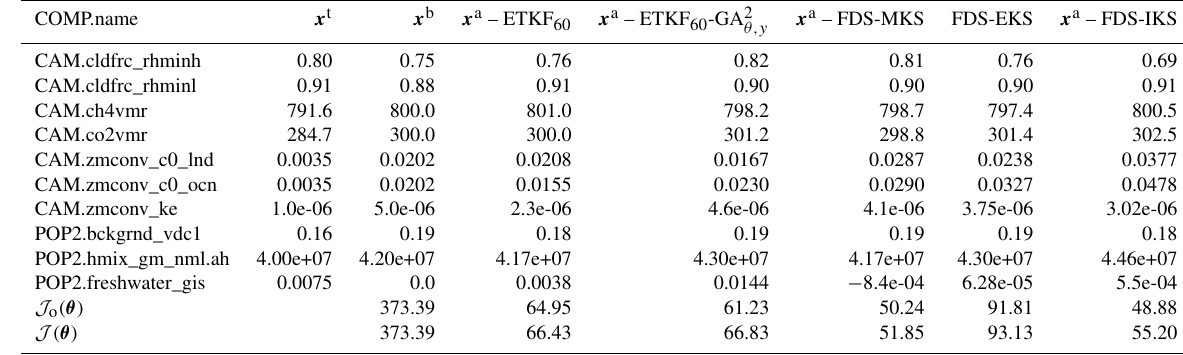
Table 5. CESM control vector estimation 1